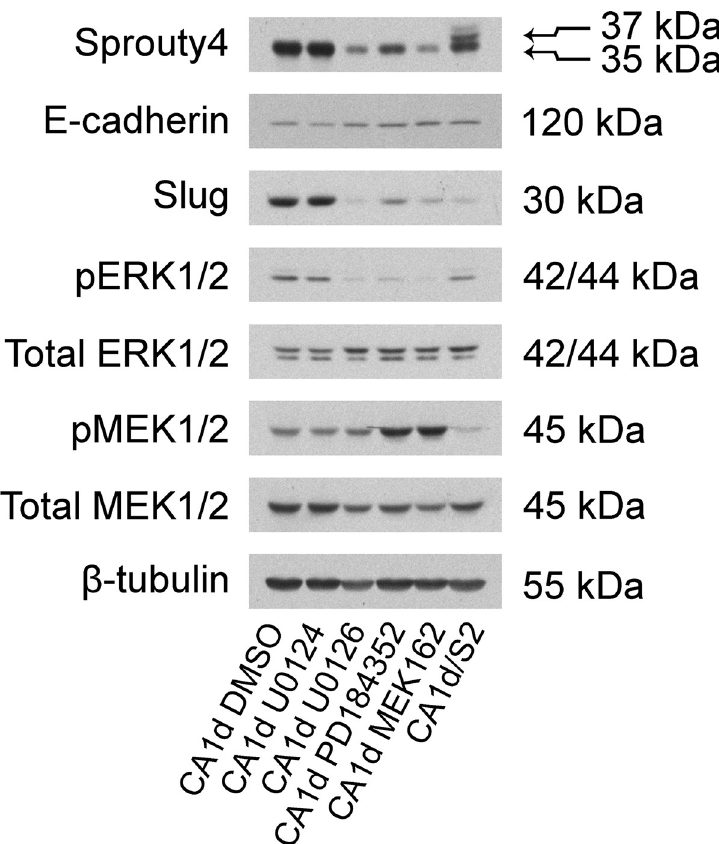
Fig 4. Sprouty4 regulates and responds to the ERK/MAPK pathway. The ERK/MAPK pathway was targeted in MCF10.CA1d cells cultured in 2D using three separate MEK1/2 inhibitors: U0126 (10 μ M), PD184352 (100 nM) and MEK162 (100 nM) for 48 hours. U0124 (10 μ M) is a negative control for U0126. Membranes were immunoblotted for Sprouty4, E-cadherin, Slug, phosphorylated ERK1/2 (pERK1/2), phosphorylated MEK1/2 (pMEK1/2), total ERK1/2, total MEK1/2, and β -tubulin. Expression levels are representative of three independent